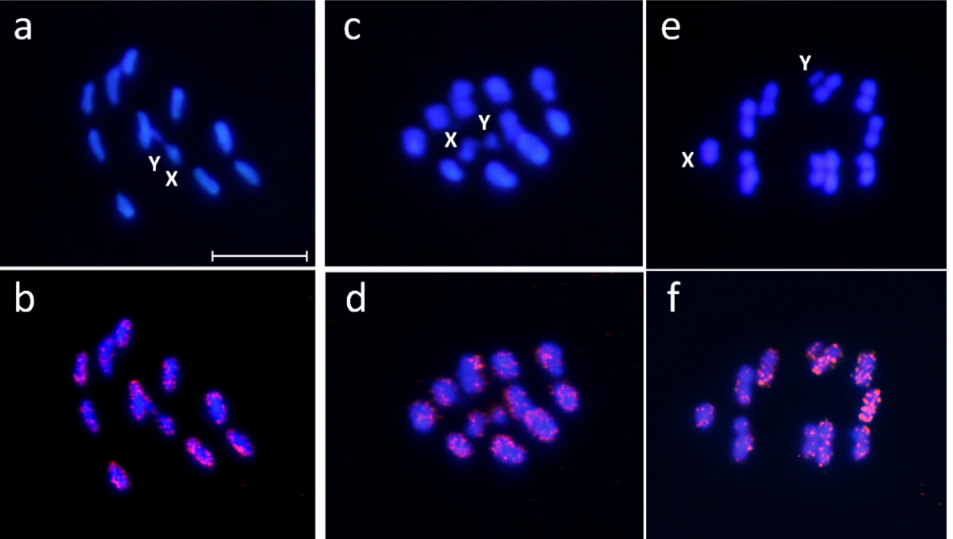
Figure 6. Chromosomal location of most abundant satDNA families of Rhodnius prolixus . Male meiotic metaphases stained with DAPI ( a , c , e ). Merged images of FISH with RproSat01-165 probe ( b ), RproSat02-169 probe ( d ) and RproSat03-124 ( f ). Scale bar = 10 µ